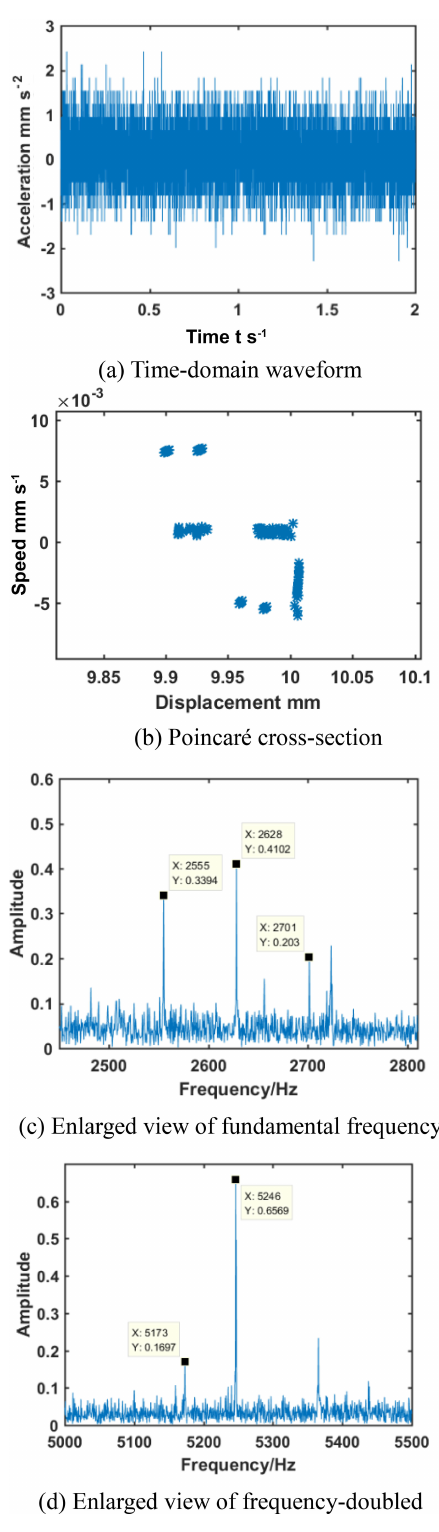
Figure 14. Time-domain signal and spectrogram of the normal gear at n = 4380rmin − 1